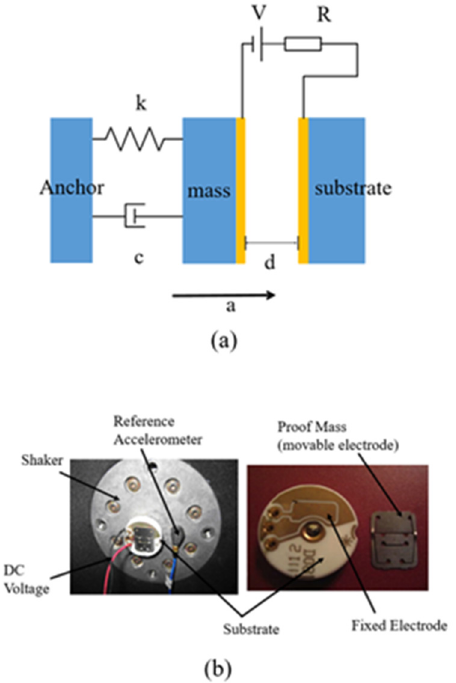
Figure 1. ( a ) The spring-mass -damping system model of inertial switches; ( b ) pictures of a capacitive accelerometer fabricated and its experimental setup built by Younis (2007 [70]).